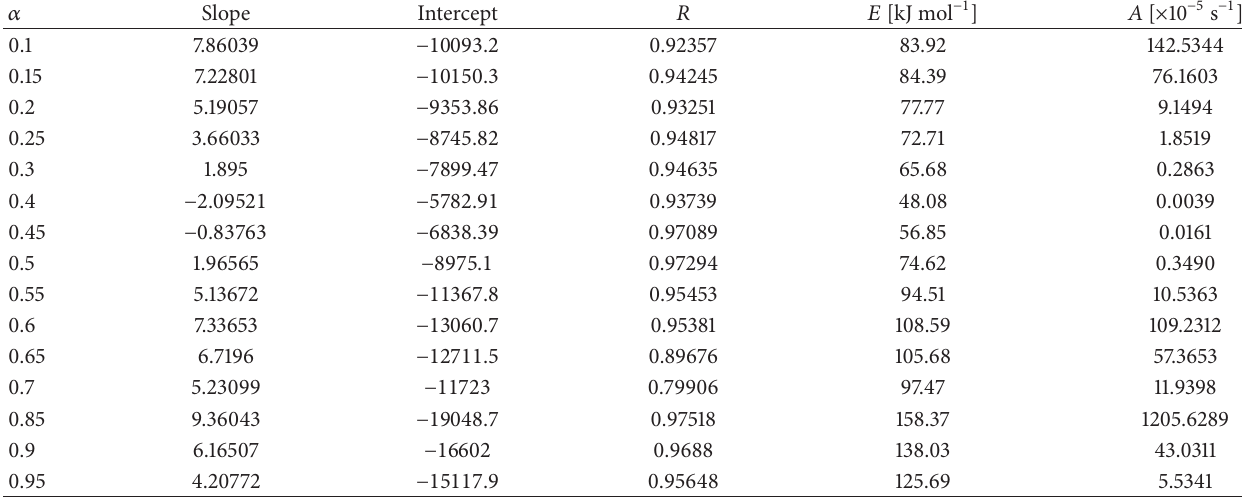
Table 4: Kinetic parameters under nonisothermal condition within different conversion